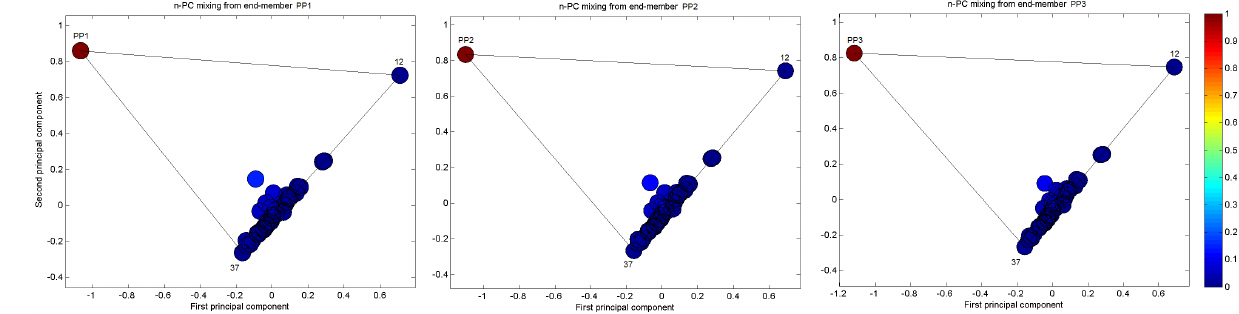
Figure 7. PCA plots of the M3 model from mixing of hydrothermal fluids with cold groundwater and polluted